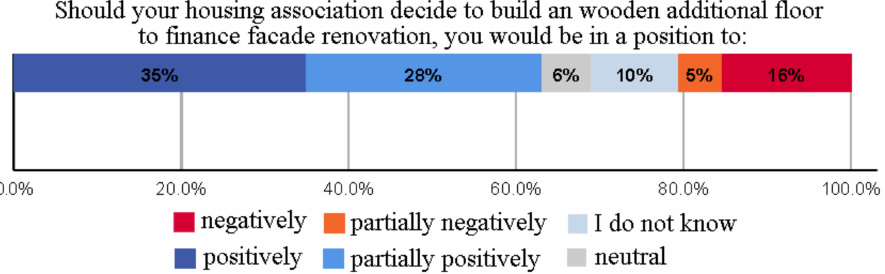
Figure 8. Attitudes of apartment building owners towards their own housing company’s wooden additional floor project to finance facade